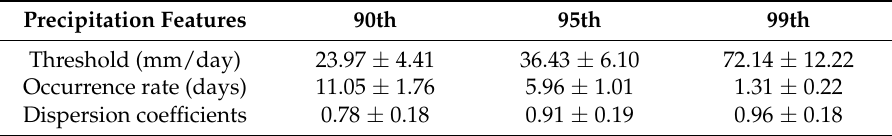
Table 1. Precipitation features at different percentiles in the MLR-YR from 1961 to 2012.